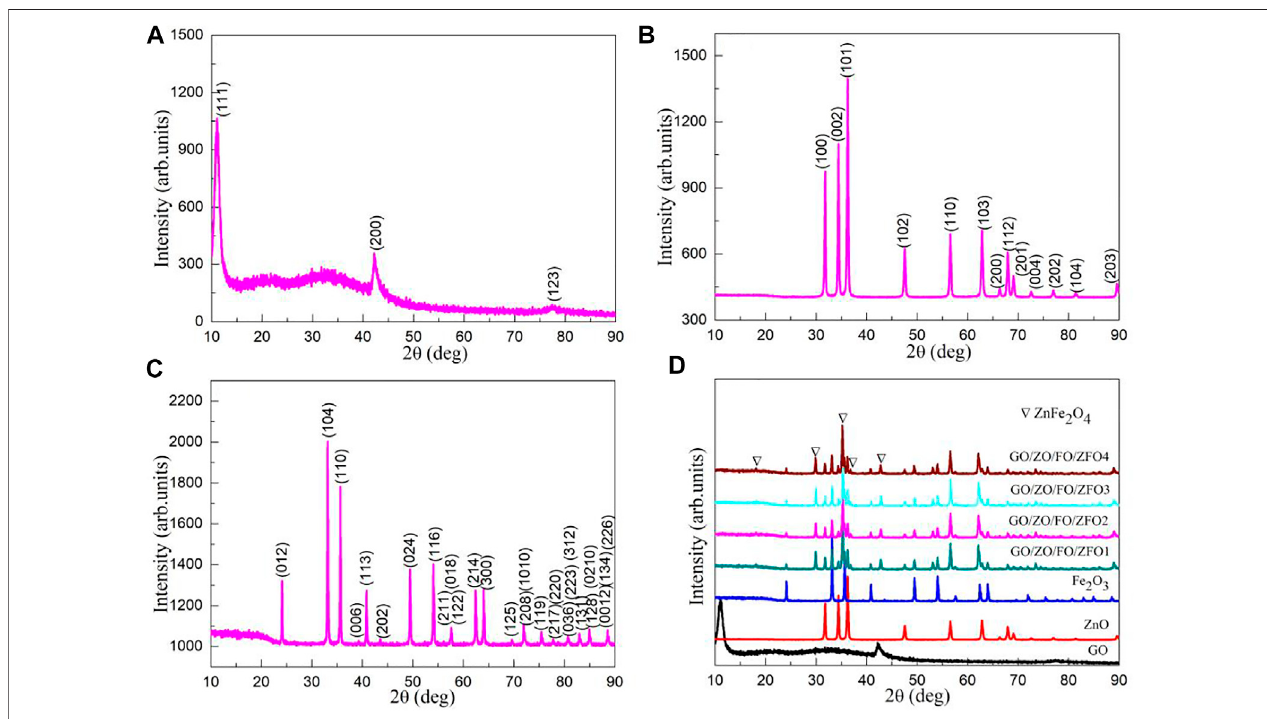
FIGURE 2 | XRD patterns of samples (A) GO, (B) ZnO, (C) Fe 2 O 3 , (D) GO/ZO/FO/ZFO1, GO/ZO/FO/ZFO2, GO/ZO/FO/ZFO3, and GO/ZO/FO/ZFO4.